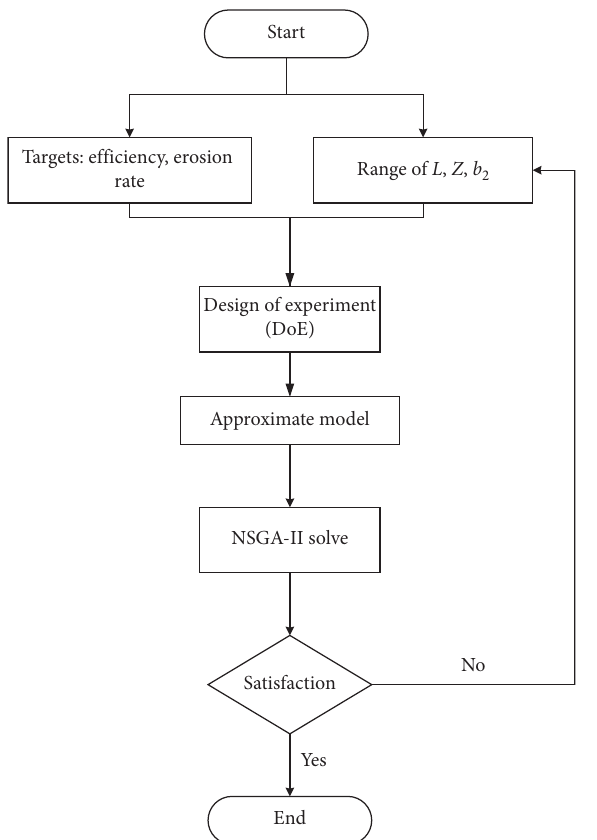
Figure 6: Process of optimization of flow chart. Table 3: Values of factors and levels. Level